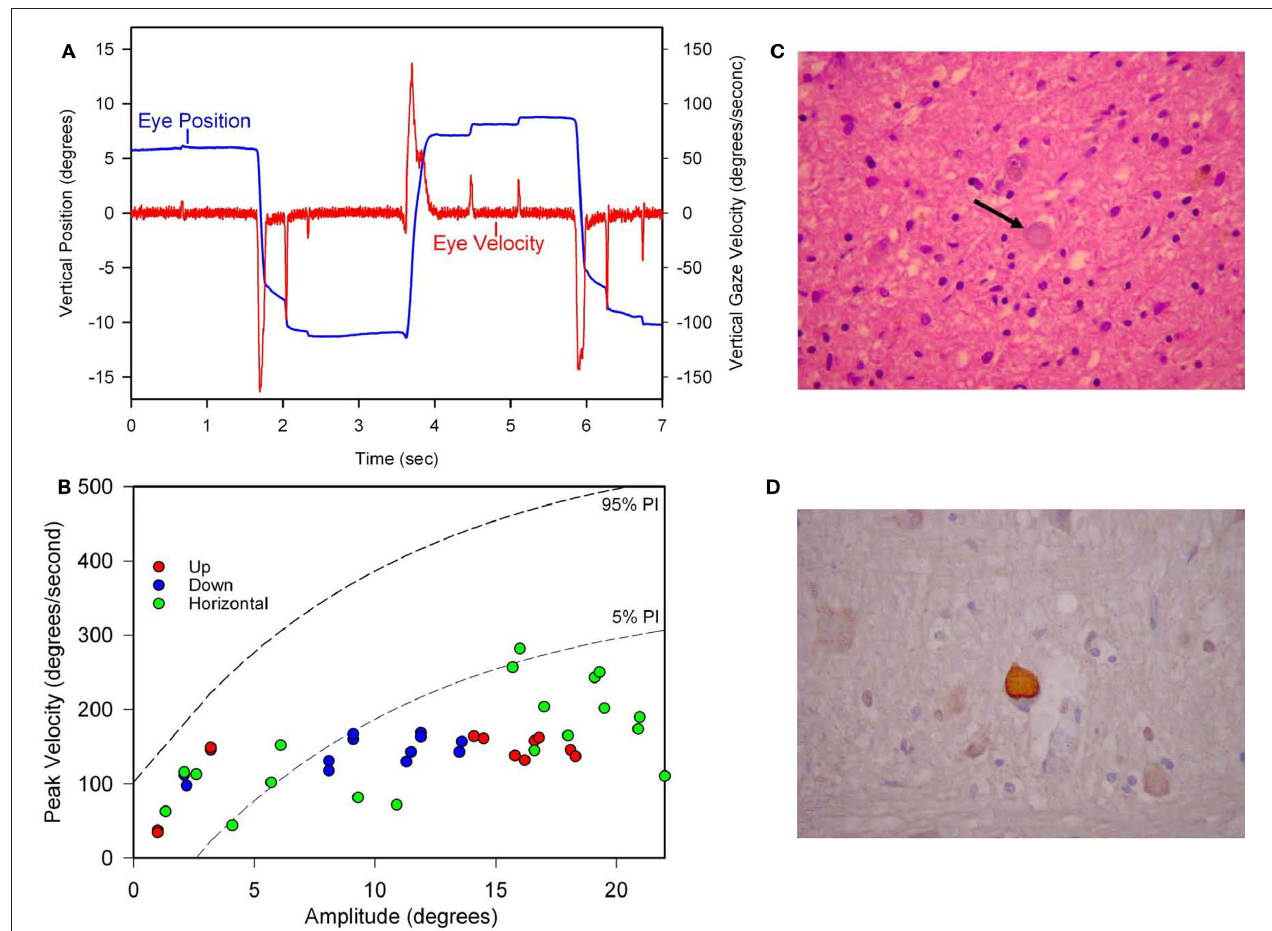
Figure 9 | Summary of findings from Patient 1 with pure akinesia. (A) Vertical saccades 14 years after the onset of his illness showed modest slowing and hypometria. (B) Comparison of peak velocity of vertical and horizontal saccades with 10 age-matched normal subjects (for whom 5 and 95% confidence intervals are shown by dashed lines). Larger saccades made by